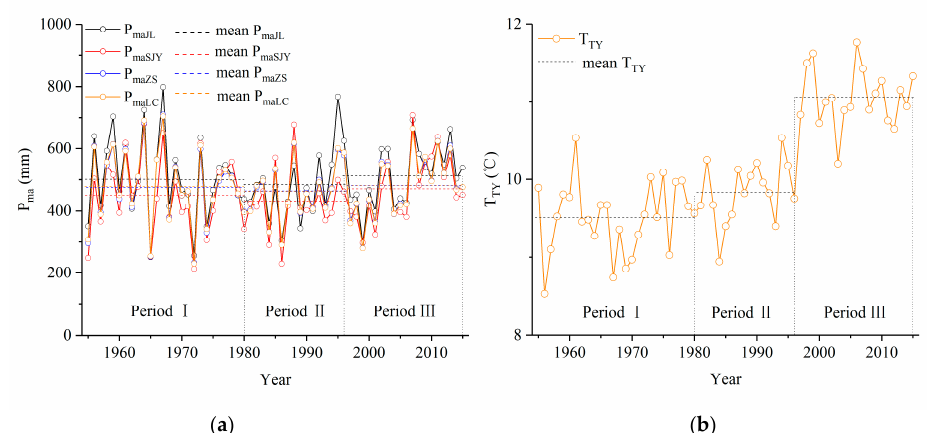
Figure 6. Temporal variation in ( a ) P maJL , P maSJY , P maZS , and P maLC from 1955 to 2015; ( b ) T TY from 1955 to 2015.